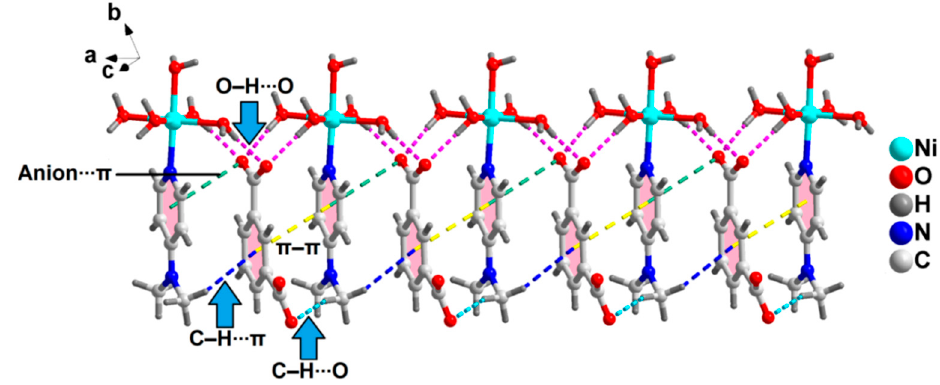
Figure 3. The1D supramolecular chain of compound 1 along the crystallographic a axis.